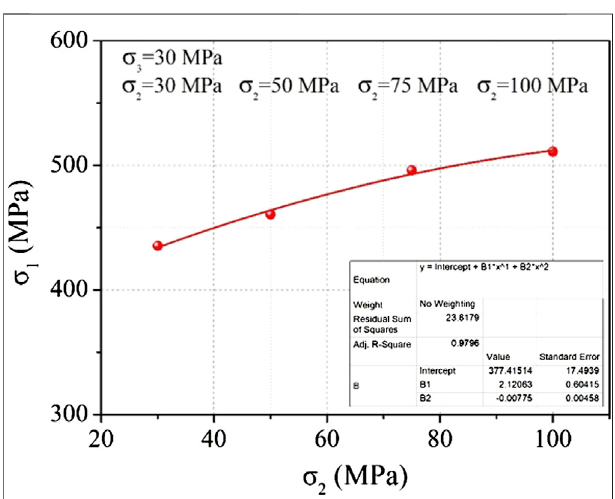
FIGURE 8 | Peak strength of granite samples adopted in the true triaxial